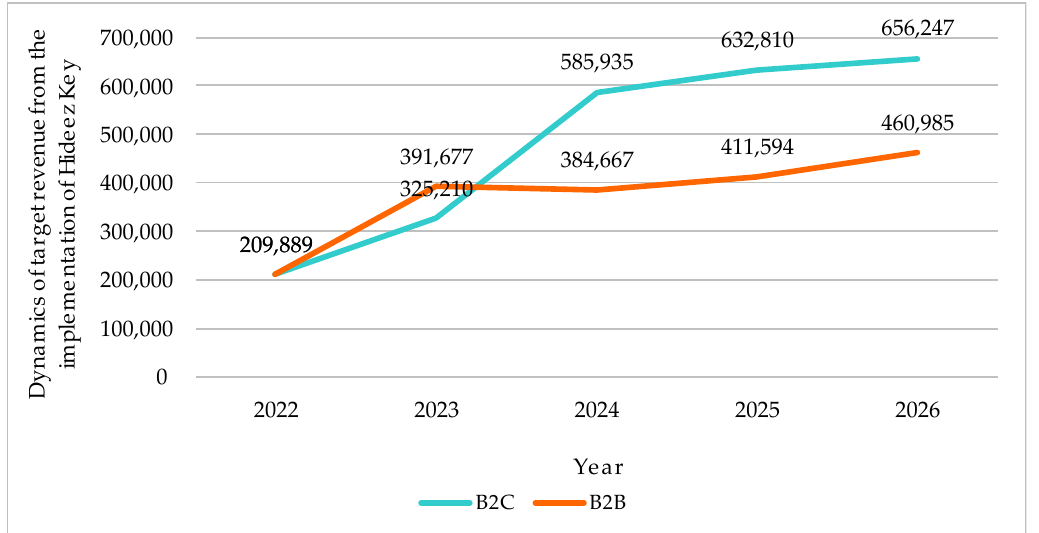
Figure 5. Dynamics of planned revenue from the implementation of Hideez Key in 2022–2026, US dollars.